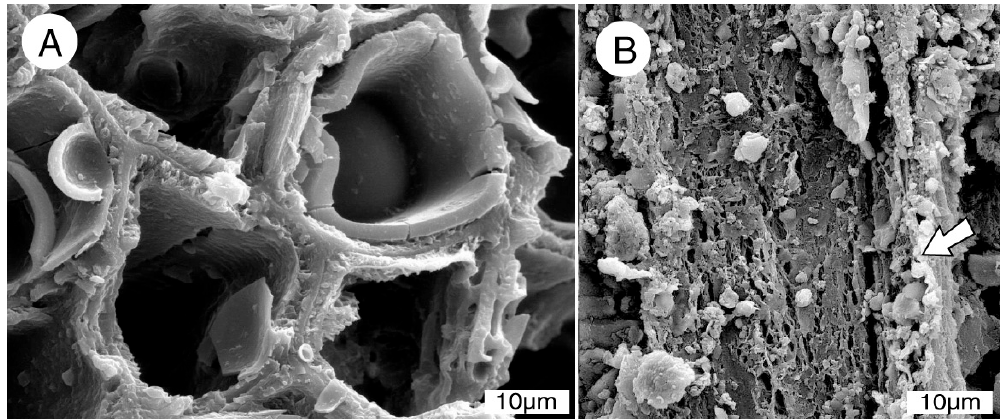
Figure 10. Eocene conifer wood from Red Hills Lignite Mine, Choctaw County, AL, USA. ( A ) Mummified wood, oblique transverse orientation, showing preservation of multi-layered cell walls; ( B ) Partially silicified wood, tangential orientation, showing lace-like degradation of cell wall, and Si precipitation in f outer wall (arrow).